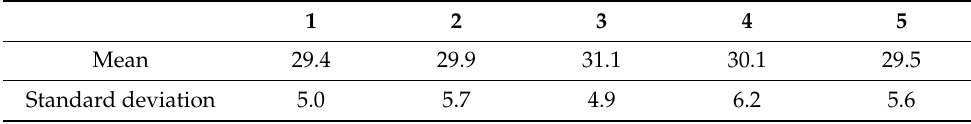
Table 1. Daily demand for the five